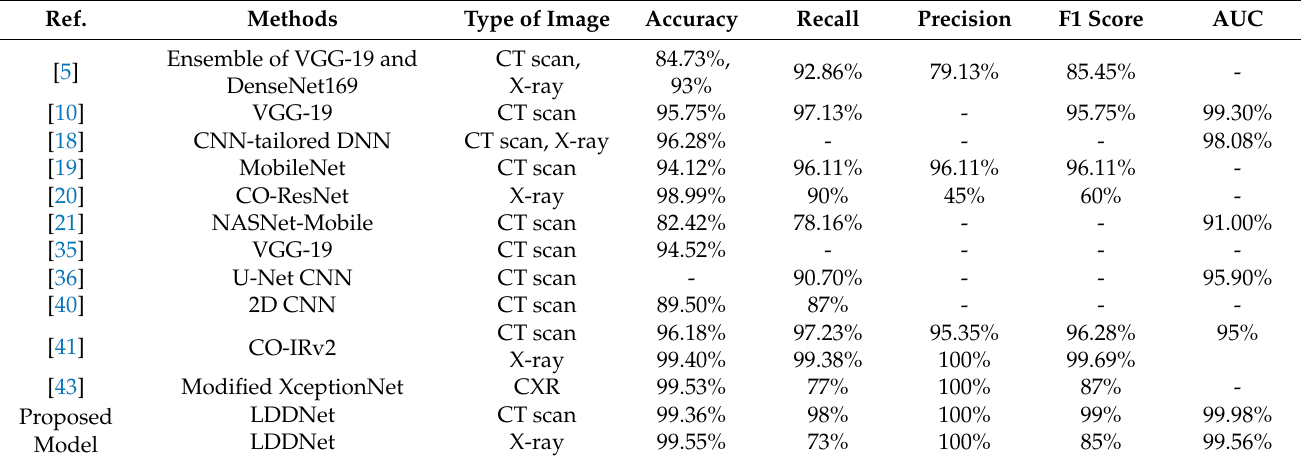
Table 14. Comparison of our proposed model with some existing